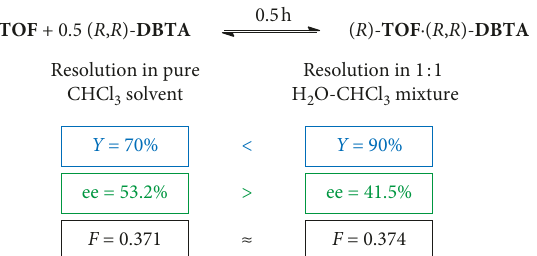
Scheme 6: Effect of water on resolution efficiency ( F � Y /100 ∗ ee/ 100) [21].